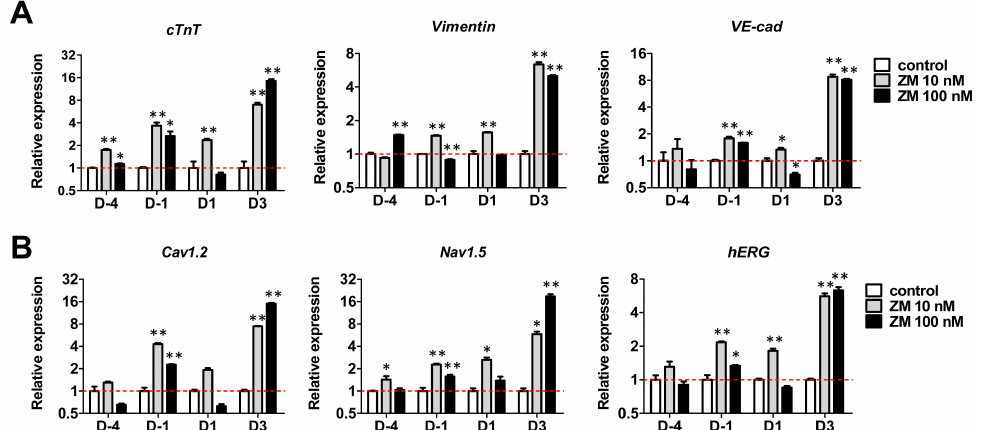
Figure 3. Effects of ZM447439 on cardiac gene expression of hiPSC-CMs: ( A ) Gene expression of the cardiomyocytes marker ( cTnT ), cardiac fibroblast (FB) marker ( vimentin ), and endothelial cell (EC) marker ( VE-cad ). ( B ) Cardiac ion channel expression of ZM-treated iPSC-CMs. Results were normalized to GAPDH expression. Data are presented as the mean ± SEM ( n = 3). * p < 0.05, ** p < 0.01, by Dunnett’s